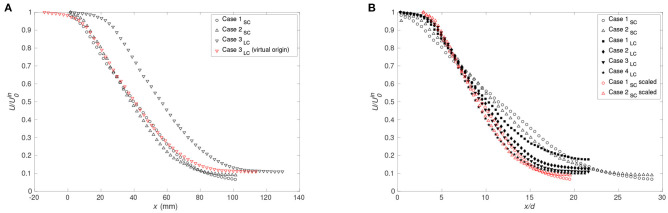
(A) Streamwise velocity normalized by inlet jet velocity vs. distance from cannula tip for Case 1SC, Case 2SC, Case 3LC as well as Case 3LC shifted by 16 mm and (B) comparison of the decay of the streamwise velocity normalized by the averaged value of the streamwise velocity on the cannula axis near its exit U0in for rc = 0 for the small cannula (Case 1SC and 2SC) and for the large cannula (Case 1LC to 4LC). The red symbols correspond to the streamwise velocity for Cases 1SC and 2SC applying the function: (x + 16)/dSC × dSC/dLC.